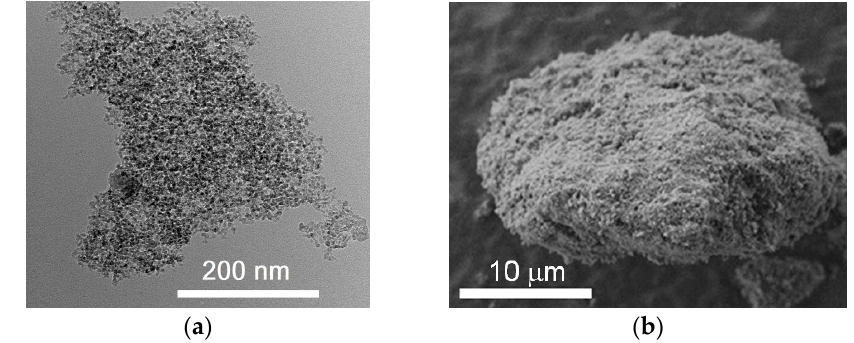
Figure 1. Transmission ( a ) and scanning ( b ) microscopy micrographs of nanodiamonds.